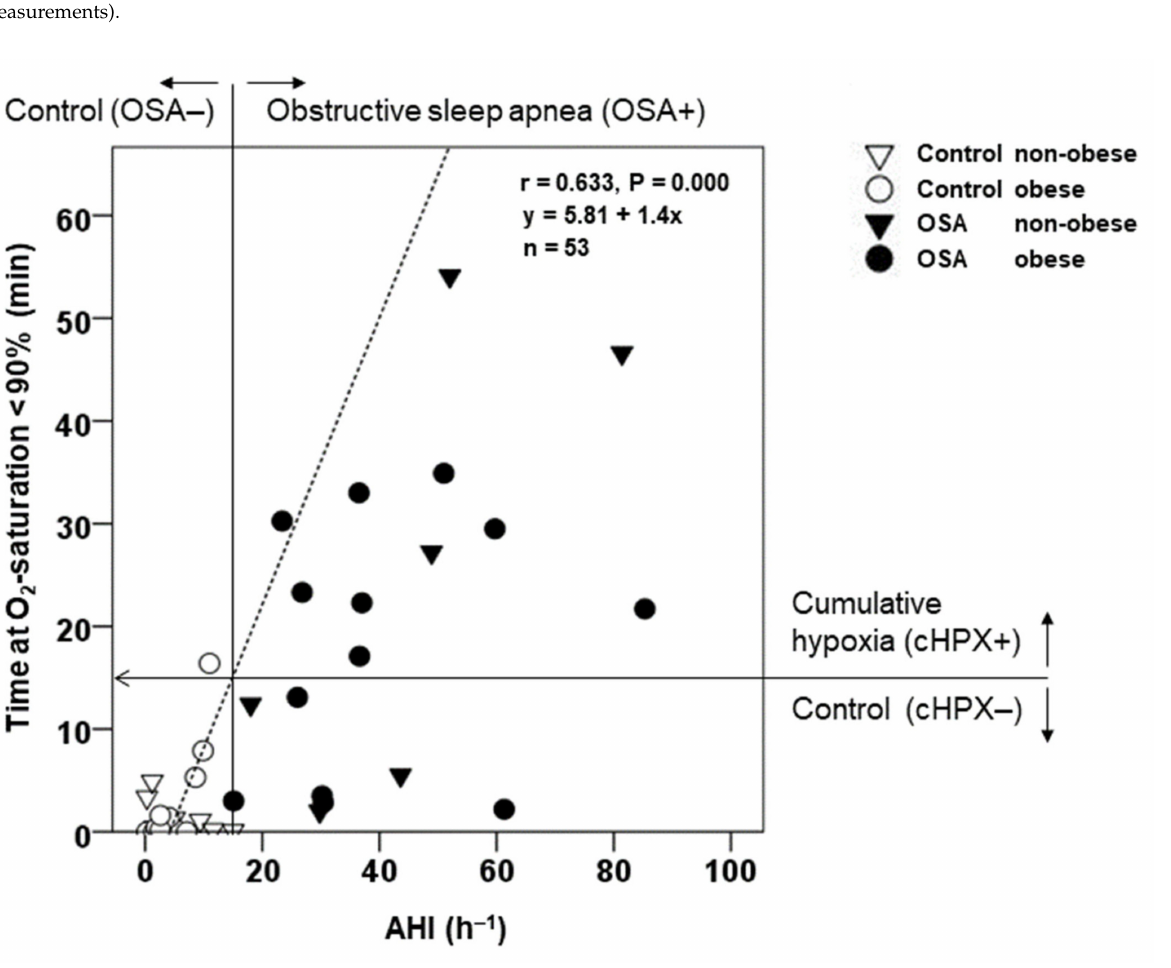
Figure 1. Correlation between individual cumulative time at O 2 -saturation < 90% (Tu90%) and the individual apnea- hypopnea-index (AHI). The graph presents the regression line and indicates the cut-off values of AHI > 15 h − 1 (vertical line) for diagnosis of moderate to severe obstructive sleep apnea syndrome (OSA) and the corresponding cut-off of Tu90% > 15.2 min (horizontal line) defining cumulative hypoxic stress (cHPX) as an explorative group assignment (see also ‘Method’ statistics section). Using this cHPX cut-off, 7 OSA patients are newly assigned to controls (without cHPX), while one OSA control subject with AHI < 15 h − 1 is newly assigned to the cHPX group. Note that for better differentiating of values around the two cut-offs, only values of Tu90% below 60 min are shown, while r, p , and the regression line within the graph represent the total study population ( n =